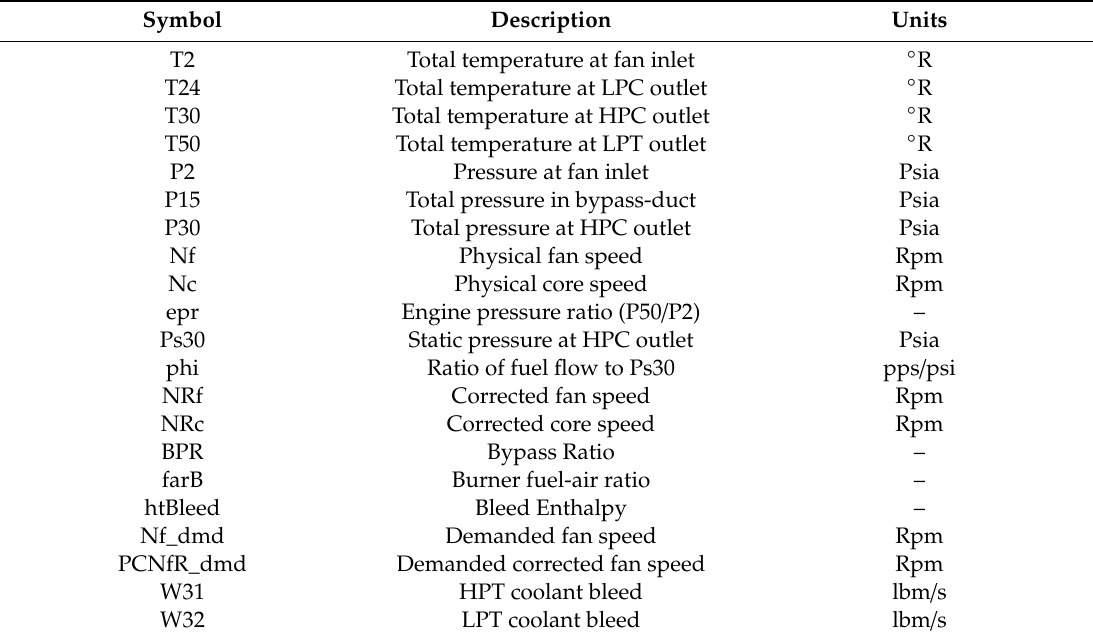
Table 1. Sensor measurements of the aircraft engine.